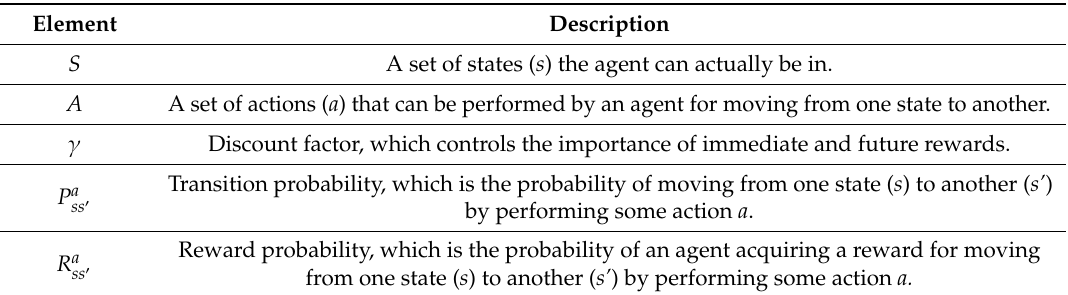
Table 9. Elements description of